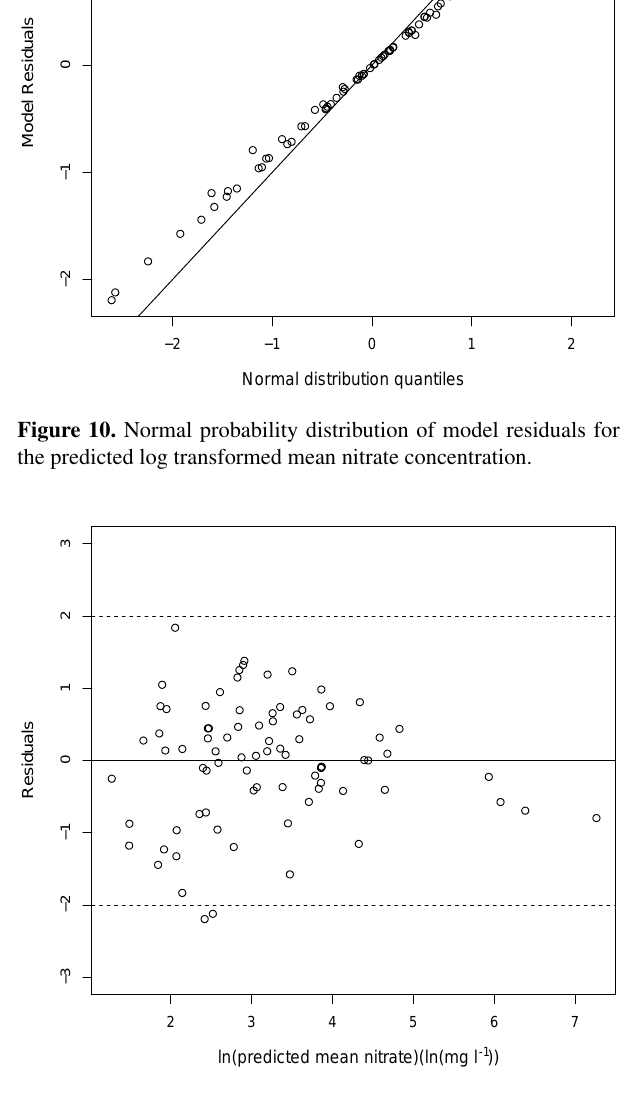
Figure 11. Relation between residuals and predicted log trans- formed mean nitrate